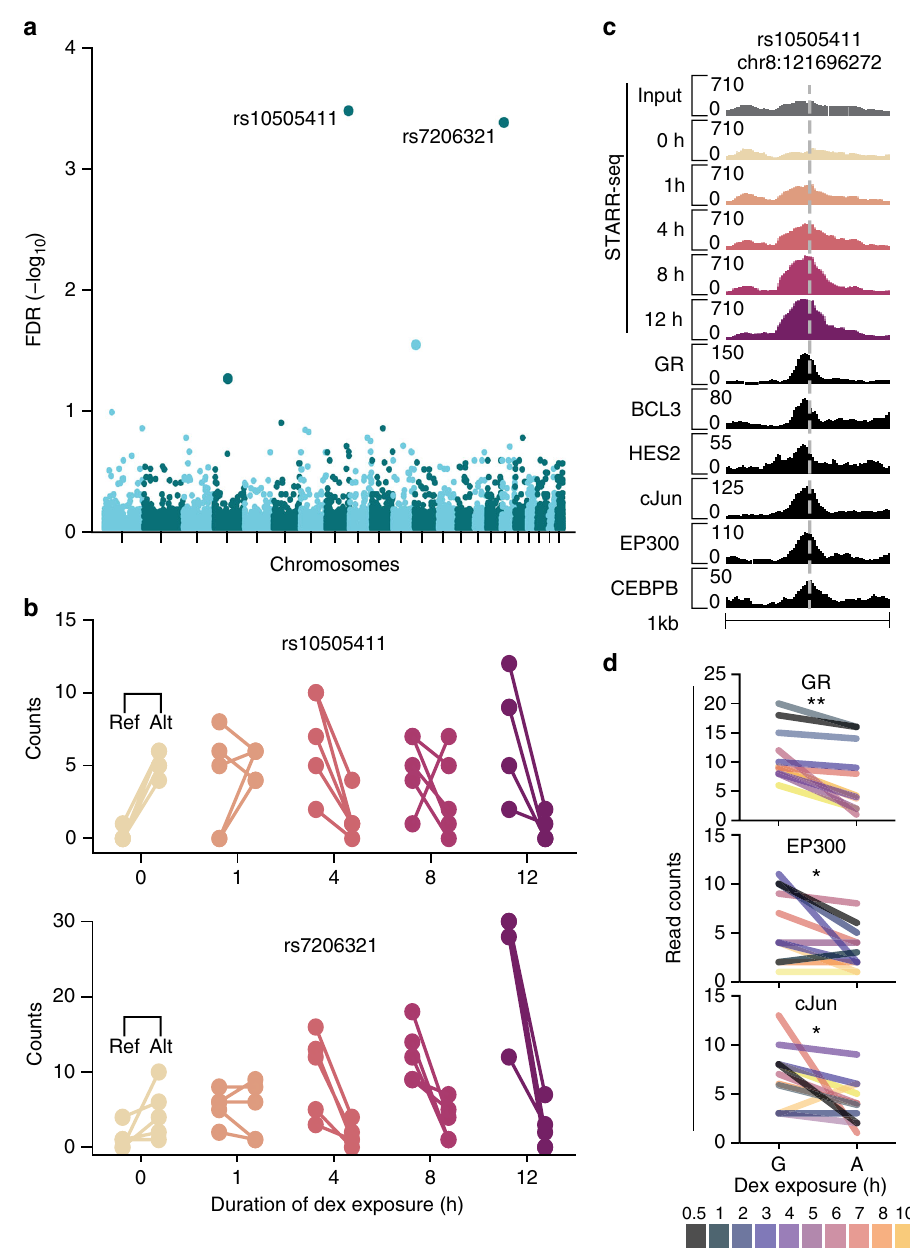
Fig. 4 Genome reporter assays detect drug-responsive allele-speci fi c regulatory activity. a Manhattan plot of genome-wide signi fi cance values for the 10,669 heterozygous SNPs overlapping a regulatory element identi fi ed in this study. b Replicate read counts at rs10505411 and rs7206321 alleles. c Rs10505411 (dashed line) is associated with active epigenomic features in A549 cells. STARR-seq was measured in RPKM and ChIP-seq was measured in input-subtracted RPKM. d TF binding at the rs10505411 reference allele is greater than that at the alternate allele following dex treatment. Total pre-dex read counts for each factor were two or less. Wilcoxon's signed-rank test, * P < 0.05, ** P <